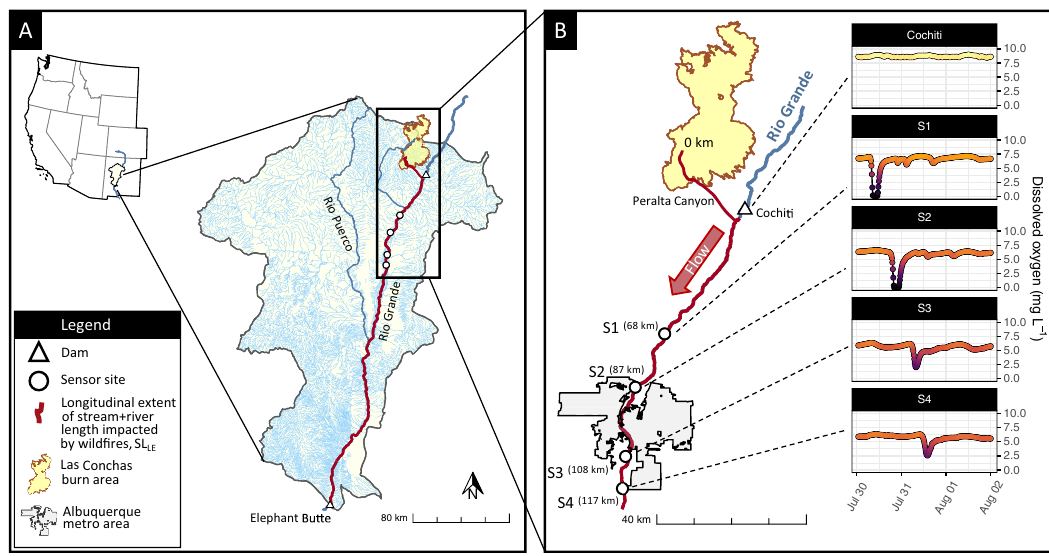
Fig. 3 Longitudinal propagation of disturbances after the Las Conchas wild fi re. A Locations of four water quality sondes deployed along the Rio Grande (New Mexico, US), which measured water quality dynamics pre- and post- fi re. B Example of the measured downstream progression of a dissolved oxygen (DO) sag originating from the headwaters of Peralta Canyon; this and three other DO sag events were used to predict the longitudinal extent of the stream + river length impacted by wild fi re disturbances (SL LE ) beyond the S4 sensor (see panel A ). A DO sensor located 220 m below Cochiti Dam and 4 km upstream of the Peralta Canyon con fl uence exhibited no DO sag, likely because the reservoir has long residence times and a turbulent release that favors fast